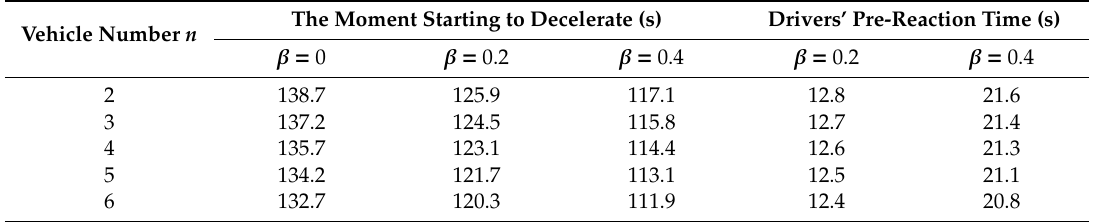
Table 2. The moments starting to decelerate for vehicles numbered n = 2, 3, 4, 5, 6. Vehicle Number